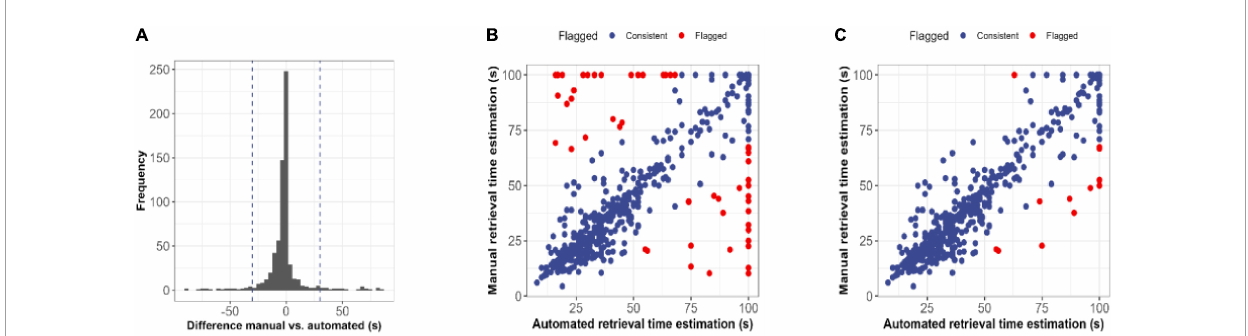
FIGURE3 Post-processing quality control of retrieval time estimations. (A) Histogram representing the difference in seconds between manual and automated estimations of the retrieval time. Automated estimations of retrieval time were on average 2.4 s faster than manually registered estimations. (B) Scatterplot displaying the relationship between raw manual and automated estimations. Differences smaller than 30 s were accepted and shown in blue, whereas differences larger than 30 s were flagged for visual inspection. (C) Scatterplot displaying the relationship between corrected manual and automated estimations. After visual inspection of the flagged estimates of figure, the final estimate was either accepted (red) or corrected to the manual estimation.